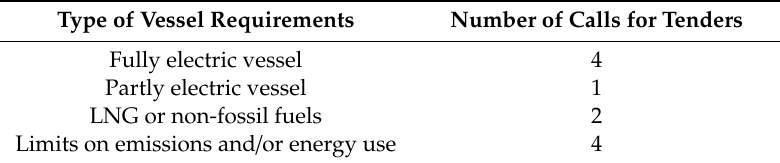
Table 2. Vessel requirements on propulsion and emission